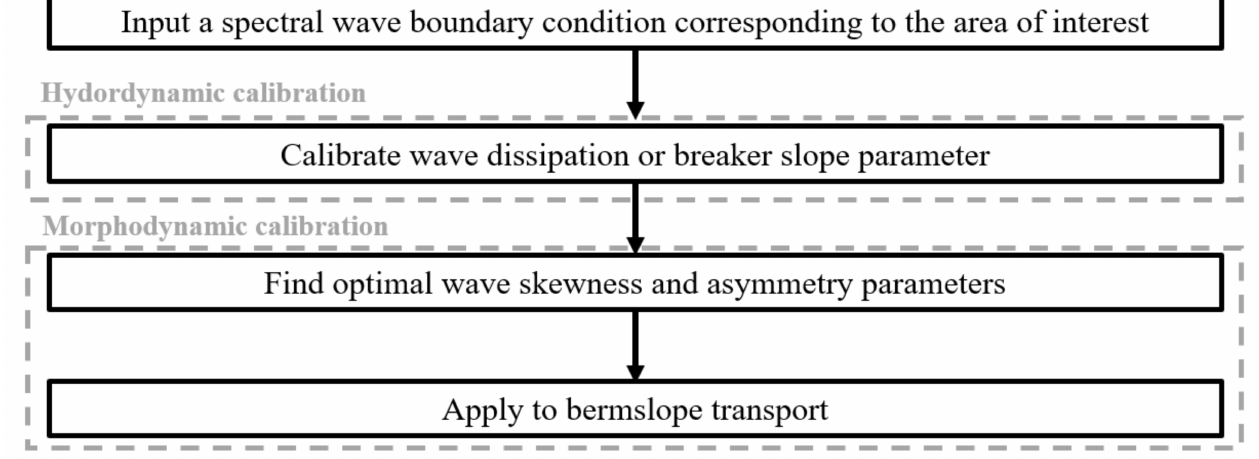
Figure 2. Flow chart of the calibration procedure in the present study: Hydrodynamic and morphodynamic calibration subcategorize one and two steps each, resulting in three sequential